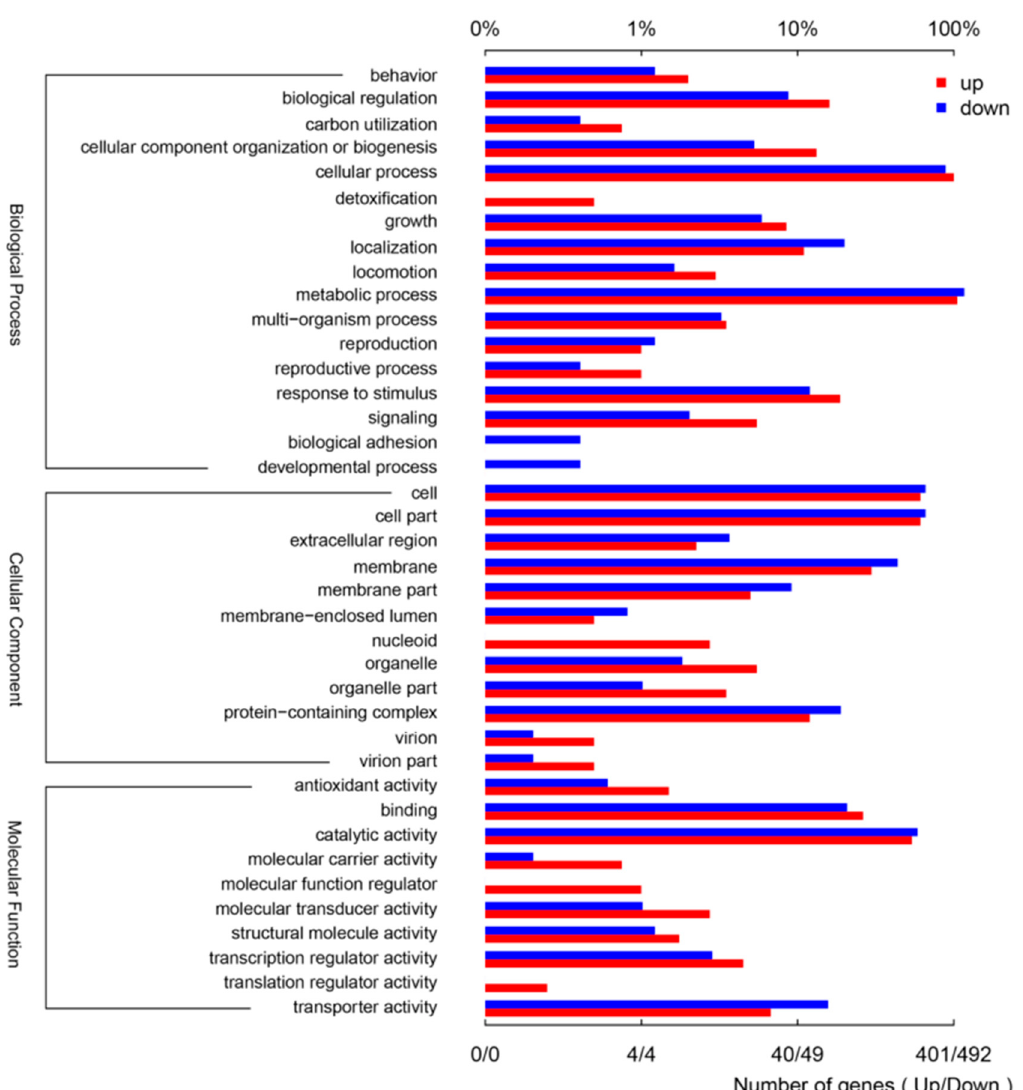
Figure 3. Chart summarizing the results of Gene Ontology enrichment analysis under salt treatment. Three categories, namely, biological processes, cellular components, and molecular functions, are shown. Up and down classi fi cation of differentially expressed genes are also marked.